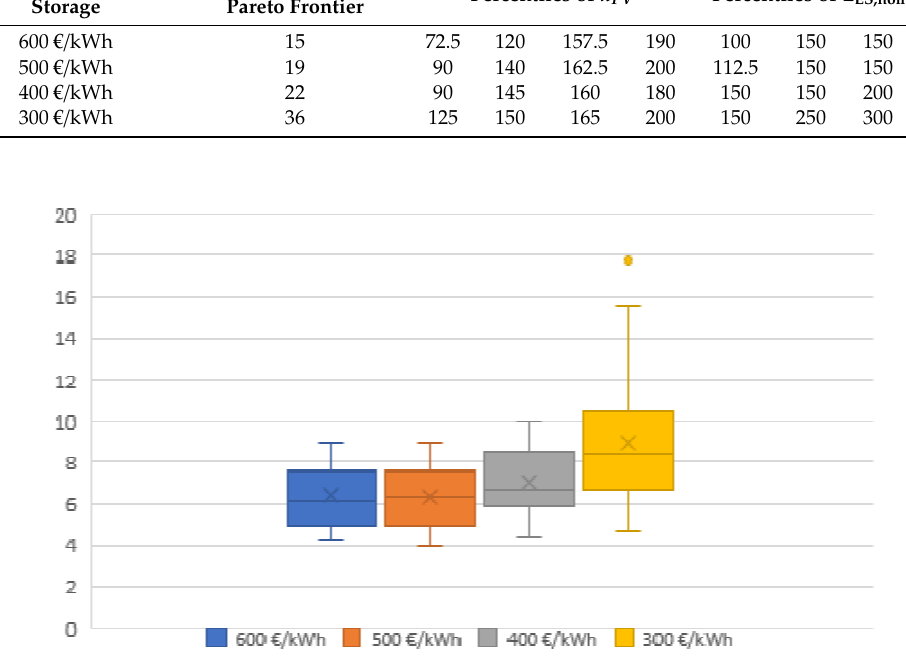
Figure 19. Ratio between the nominal electrochemical storage capacity and the PV capacity depending on ES unitary price. Energies 2019 , 12 , x FOR PEER REVIEW